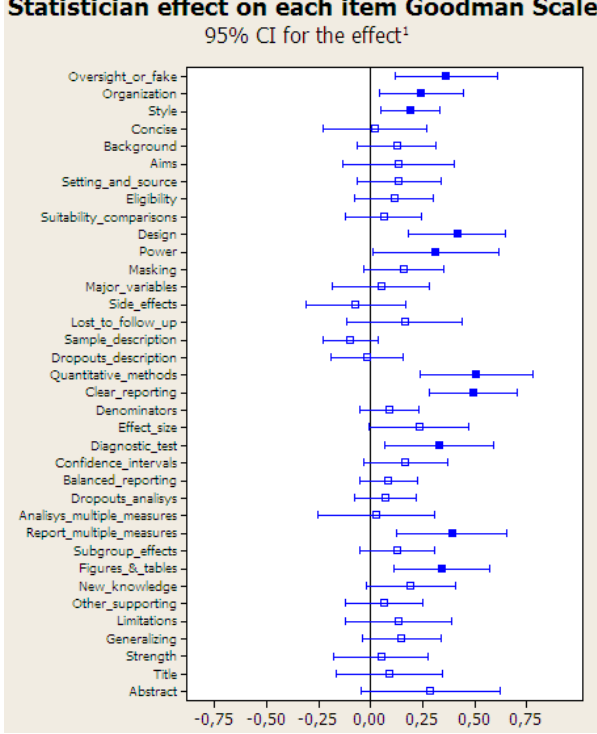
Figure 4. Estimated effect of statistical review over the 36 Goodman items . Solid boxes indicate statistically significant effects. 1 Differences in improvement from baseline between groups with and without statistical reviewer